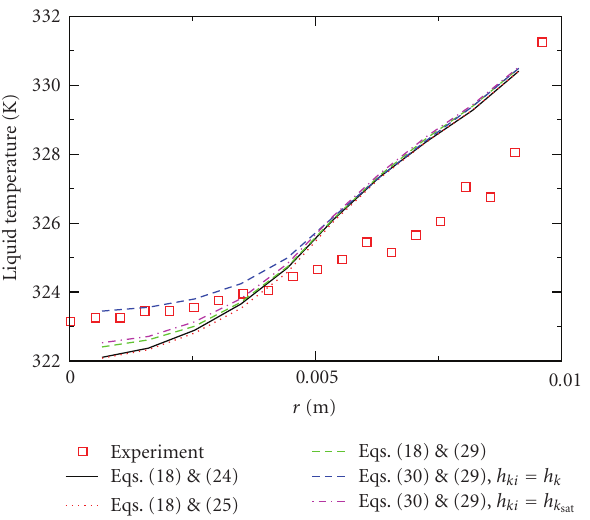
Figure 5: comparison of the di ff erent models on the Sauter mean diameter profile.